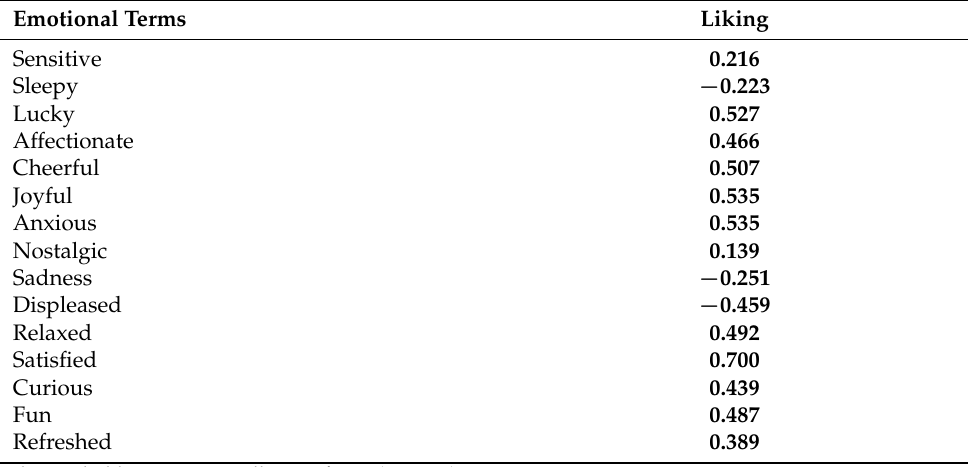
Table 3. Pearson correlation between liking and emotional terms.